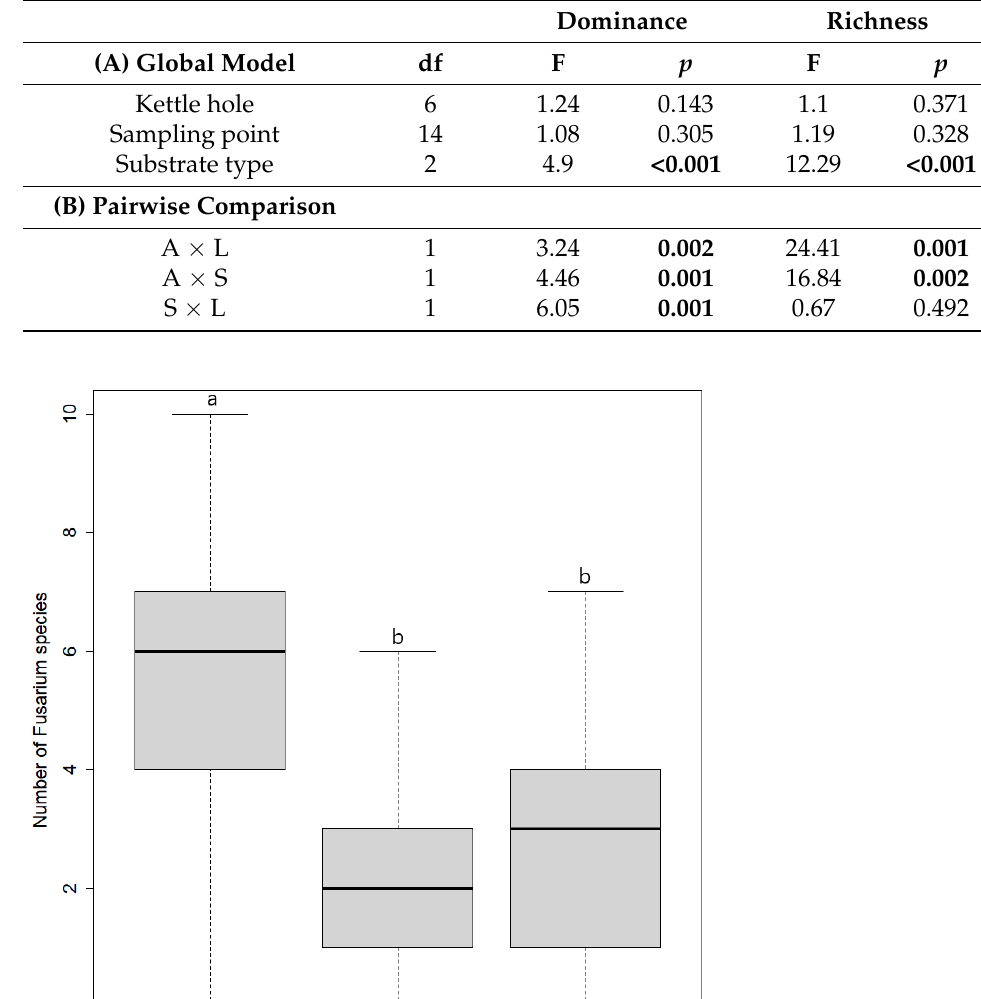
Table 2. Effects of the different kettle holes, sampling points and substrate types arthropods (A), litter (L), soil (S) on the species composition of Fusarium communities based on relative abundances (Dominance) and the number of identified Fusarium species (Richness) in (A) the global model and (B) pairwise post-hoc tests. Significant p -values from PerMANOVA are shown in bold.